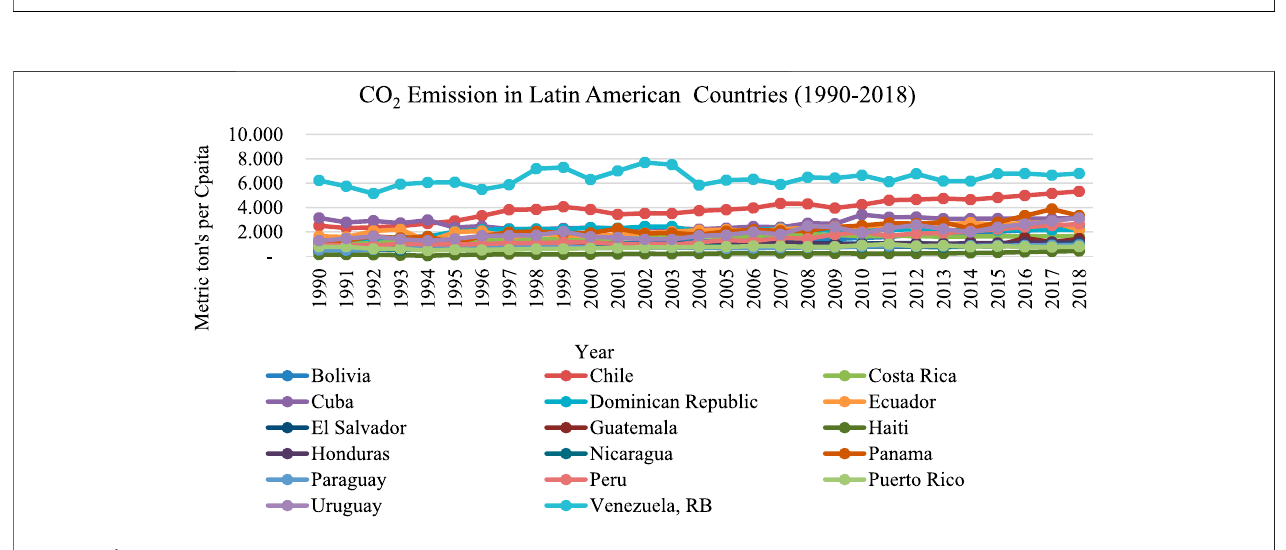
FIGURE 6 | CO 2 emission in Latin American